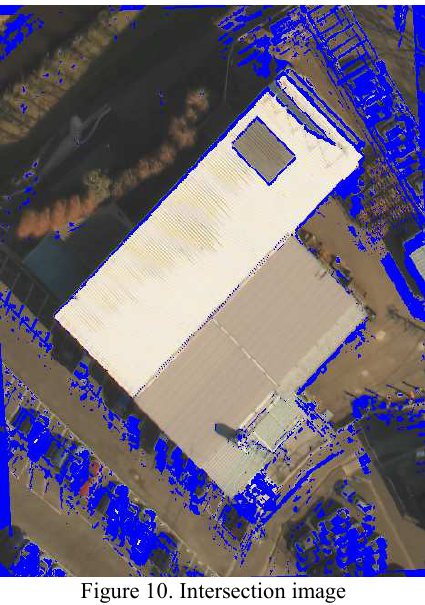
Figure 10. Intersection image